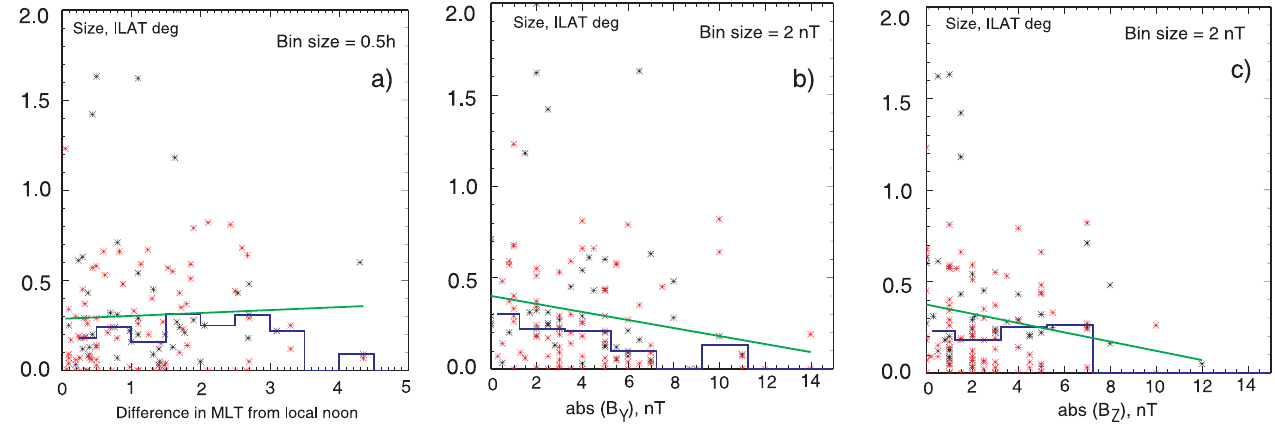
Fig. 9. Dependencies of the LLBL electron edge size from: the MLT difference from the local noon (panel a ), the absolute value of the IMF B Y -component (panel b ) and the IMF B Z -component (panel c ). The GSM coordinate system has been used. In each panel, the red points represent events where the size was estimated from the multi-spacecraft method, while the black points represent events where the size was estimated from the one-spacecraft method. The green line shows a linear least squares fit to these data, while the blue line shows the median value of the size in each bin, for cases where there are more than 3 points in a